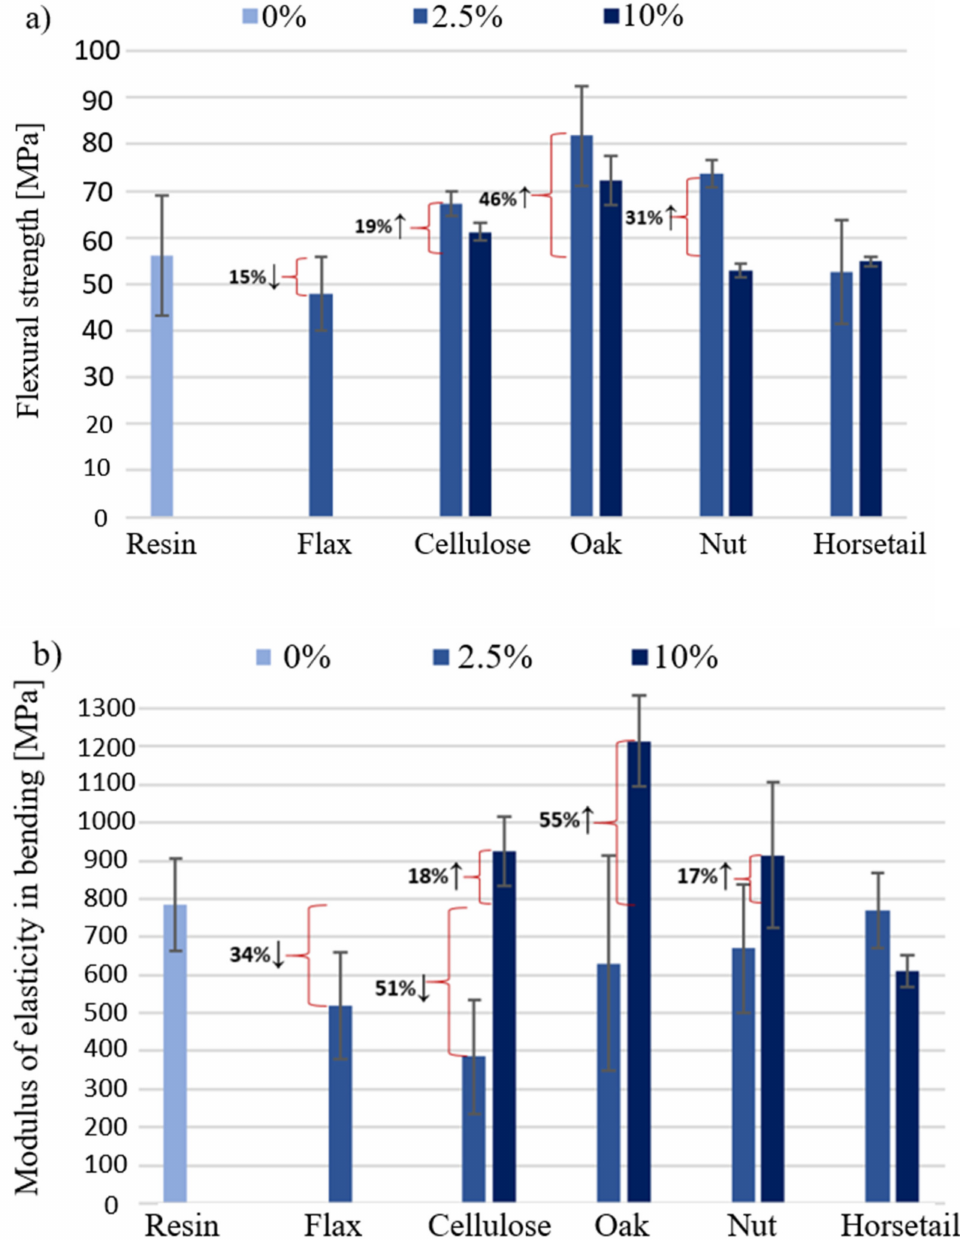
Figure 13. Bending strength ( a ) and bending modulus ( b ) of the